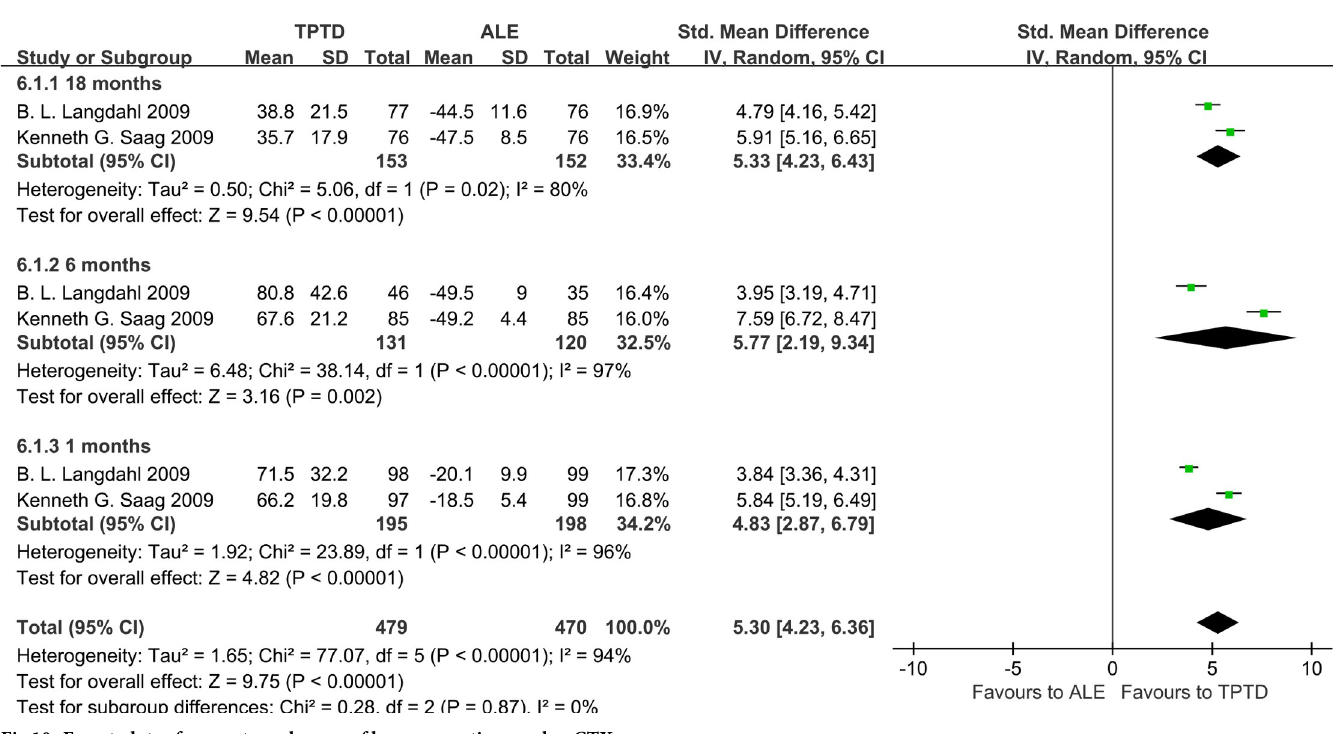
PLOS ONE | https://doi.org/10.1371/journal.pone.0267706 May 31,